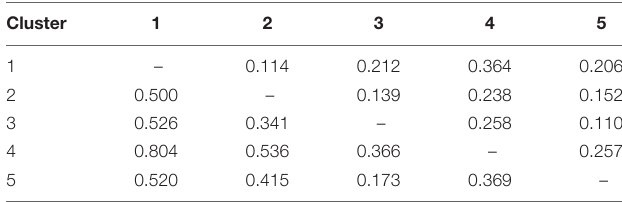
TABLE 4 | Pairwise F ST (above diagonal) and Nei’s genetic distances (below diagonal) values among the five genetic clusters. Cluster